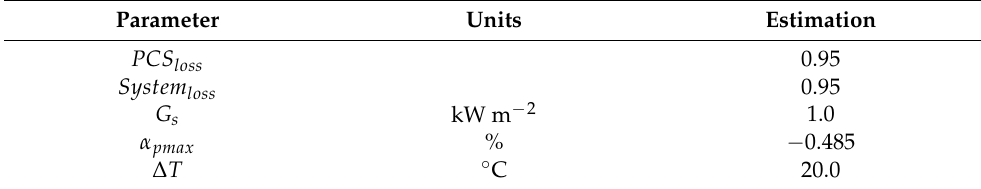
Table 4. Estimation of parameters for PV productivity model.